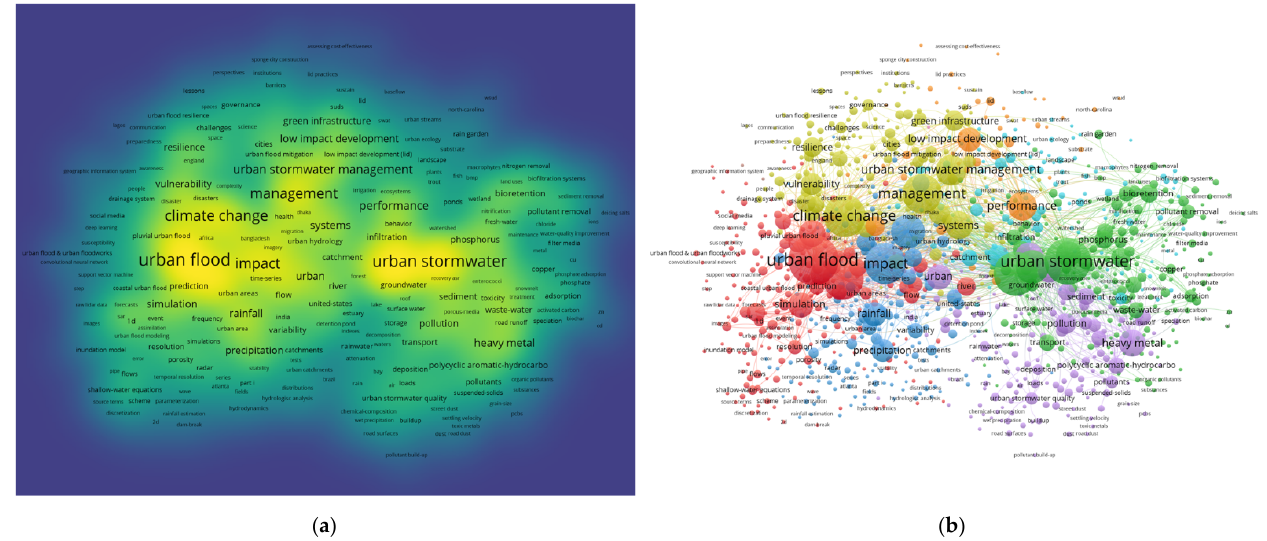
Table 2. The occurrence frequency and total link strength of the top 20 keywords.